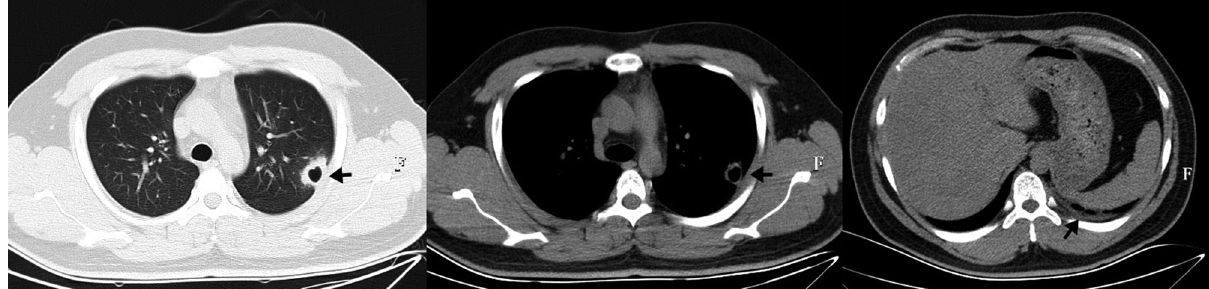
Figure 1: Chest CT before treatment, showing a thick - walled cavity in the left upper lung, with smooth inner and irregular outer margins. The adjacent pleural and the left lower pleural were thickened.